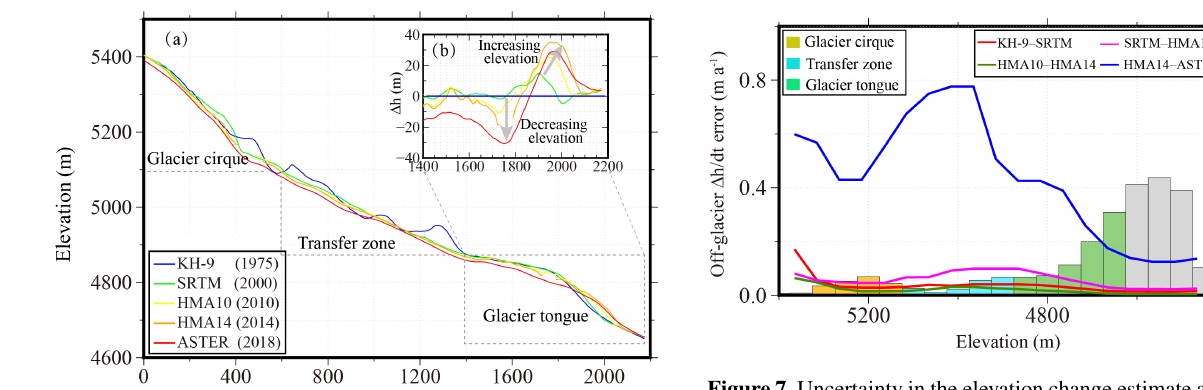
Figure 7. Uncertainty in the elevation change estimate as a function of elevation bands (the lines) in the off-glacier region. The right axis gives the frequency number of each elevation band. The elevation bands corresponding to the glacier cirque, transfer zone, and glacier tongue ranges (see Fig. 6) are filled with yellow, cyan, and green colors,